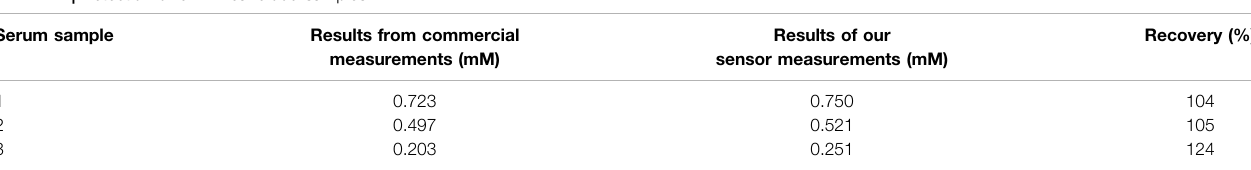
TABLE 1 | Detection of UA in real blood samples.